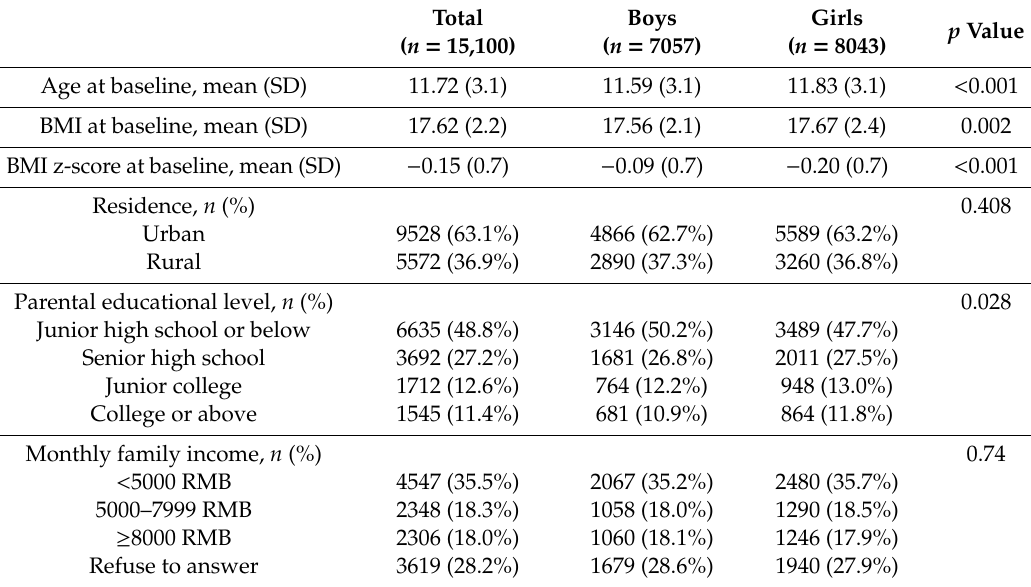
Table 1. General characteristics of children at baseline by